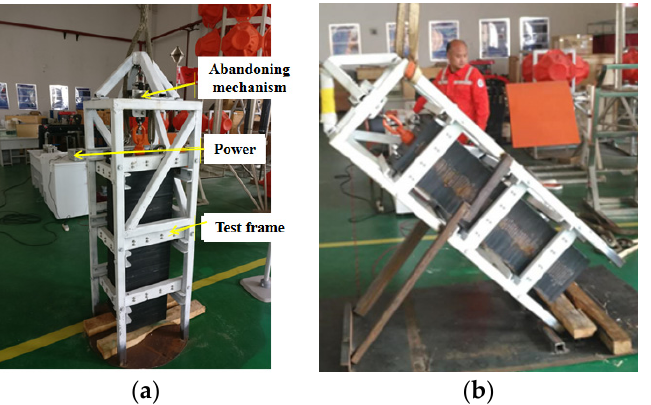
Figure 20. ( a ) Ballast abandoning test in the upright position; ( b ) ballast abandoning test in heeling